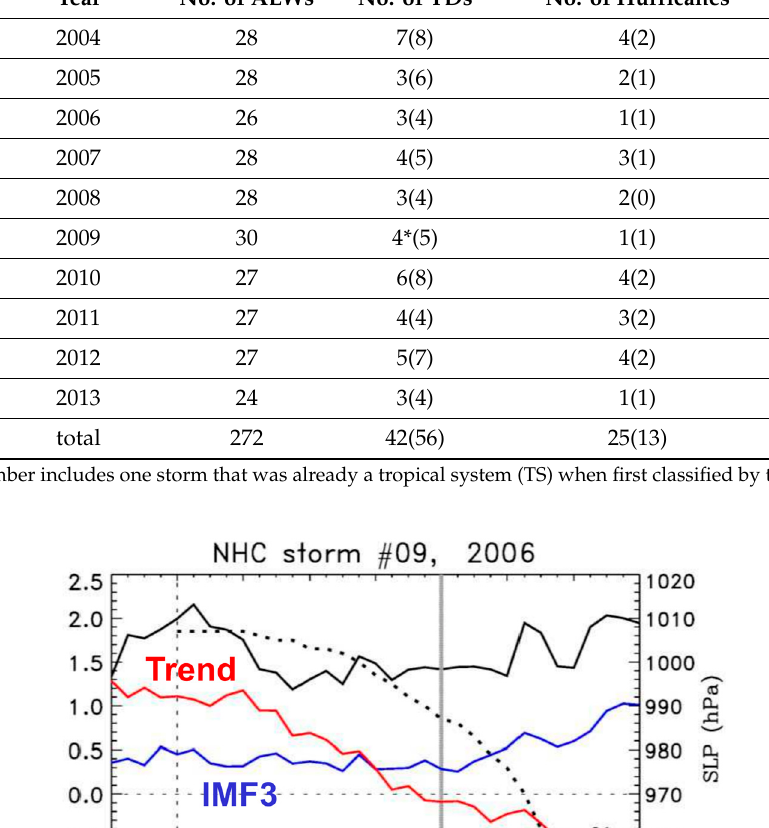
Table 3. Breakdown by year of AEWs (2nd column), the NHC tracked storms (3rd column), and hurricanes (4th column) for July, August and September from 2004 to 2013 for the main development region. In the 3rd column, numbers outside (or between) the parentheses include tropical depressions (TDs) that were (or were not) associated with AEWs. Numbers in the 4th column contain hurricanes that developed from the AEW associated storms and the numbers between the parentheses are hurricanes with downscaling features. Table was reproduced by permission of the American Meteorological Society [16].